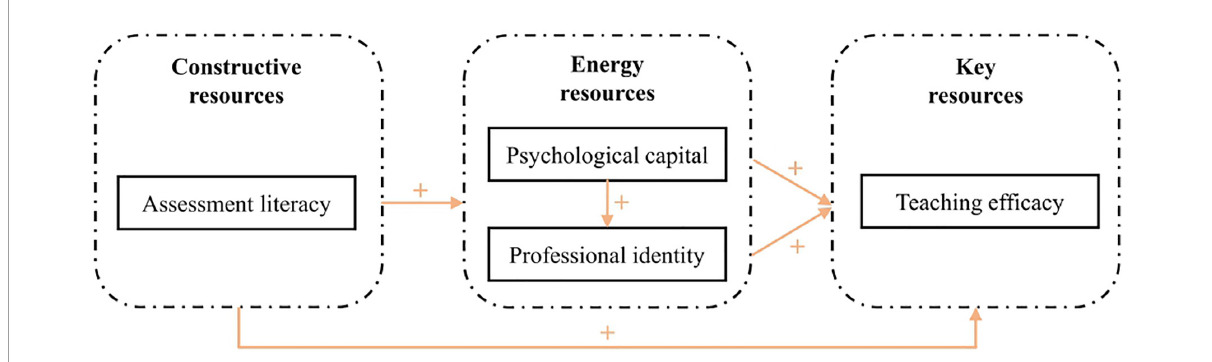
FIGURE1 A conservation of resources (COR) conceptual model of the “gain spiral” and “resource caravan” generated by the teacher’s personal resources.